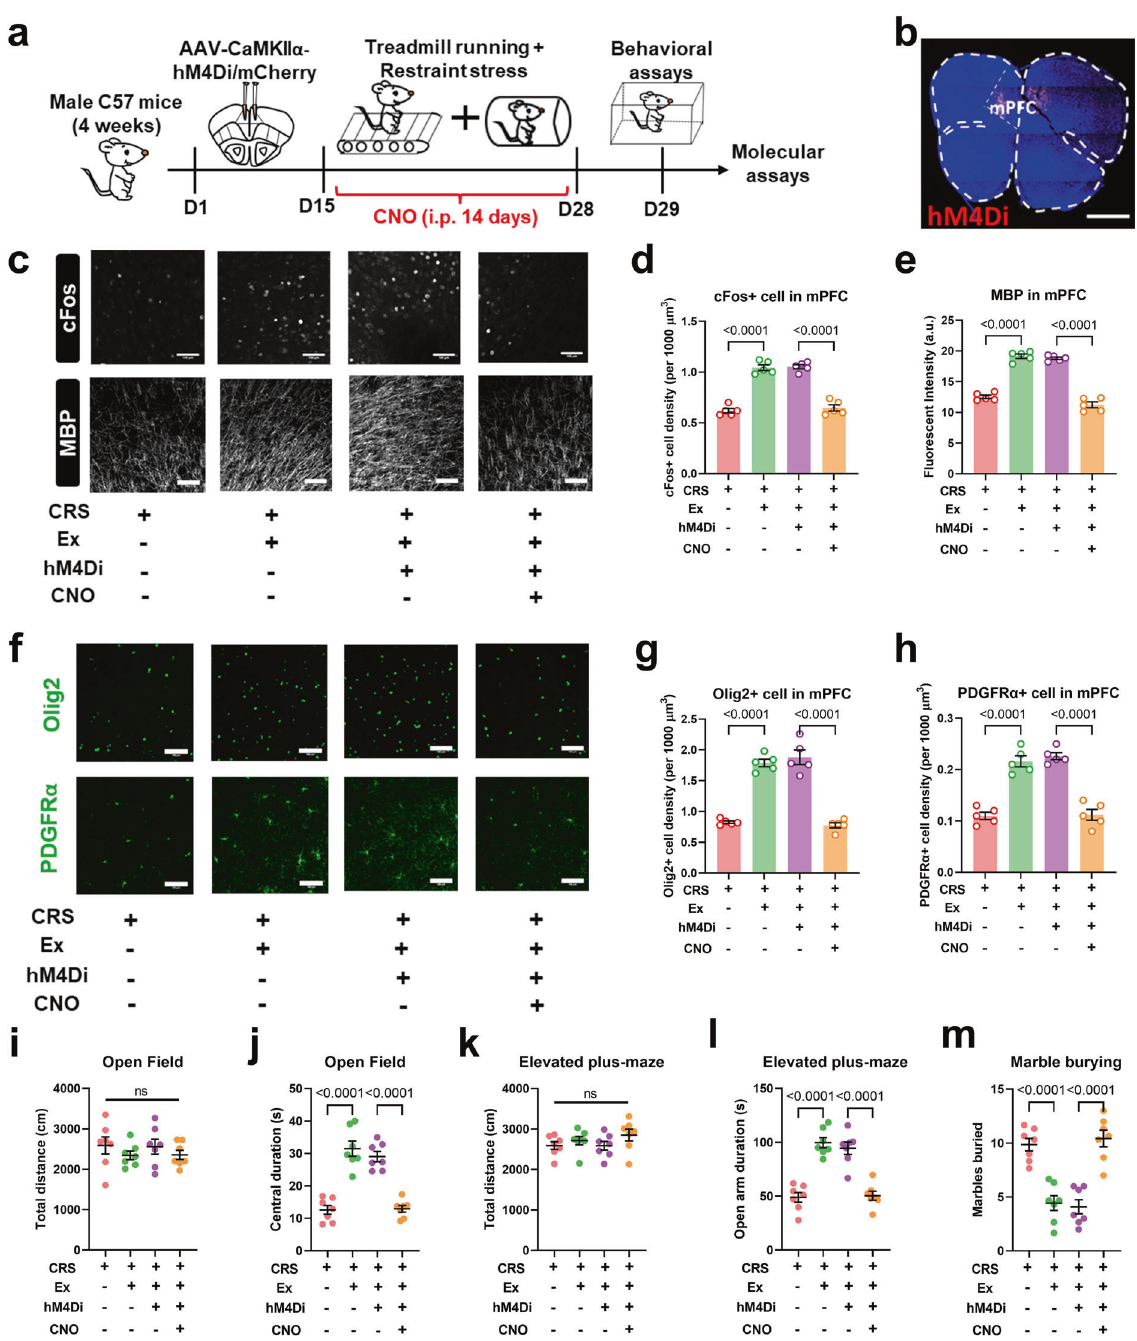
Fig. 5 mPFC neuronal activity mediates axonal myelination under the exercise paradigm. a Experimental designs of chemogenetic inhibition assay. b Infection sites of AAV-hM4Di into mPFC. Scale bar, 500 μ m. c Fluorescent images showing cFos (upper panels) and MBP (lower panels). Scale bar, 100 μ m. d Quanti fi cation of cFos suggested the potentiation of mPFC neurons under exercise training and neuronal inhibition by CNO infusion. One-way ANOVA, F (3,16) = 87.31, P < 0.0001. e MBP fl uorescent intensity (in a.u.) was depressed under neuronal inhibition. One-way ANOVA, F (3,16) = 143.3, P < 0.0001. f Fluorescent intensity of oligodendrocytes (Olig2 and PDGFR α ) in mPFC. Scale bar, 100 μ m. g Quanti fi cation showed the decreased density of Olig2 + cells after chronic inhibition of mPFC neurons. One-way ANOVA, F (3,16) = 71.57, P < 0.0001. h The density of PDGFR α cells was decreased in CNO-treated animals. One-way ANOVA, F (3,16) = 49.70, P < 0.0001. N = 5 mice in each group in ( c – h ). Tukey ’ s post-hoc test was used for comparisons between the two groups. i Total distance in the open fi eld was unaffected under mPFC neuron inhibition. One-way ANOVA, F (3,24) = 0.6556, P = 0.5873. j Time spent in the central region in the open fi eld was decreased under mPFC neuron inhibition. One-way ANOVA, F (3,24) = 37.99, P < 0.0001. k Total locomotor activity on the elevated plus maze was unchanged in CRS + Ex + hM4D + CNO group. One-way ANOVA, F (3,24) = 1.188, P = 0.3351. l Time duration in the open arm on the elevated plus maze was decreased in CRS + Ex + hM4D + CNO group. One-way ANOVA, F (3,24) = 32.61, P < 0.0001. m The number of marbles buried was increased by CNO treatment. One-way ANOVA, F (3,24) = 25.50, P < 0.0001. N = 7 mice in each group in ( i – m ). Tukey ’ s post-hoc test was used for comparisons between the two groups. All data were presented as mean ± sem.